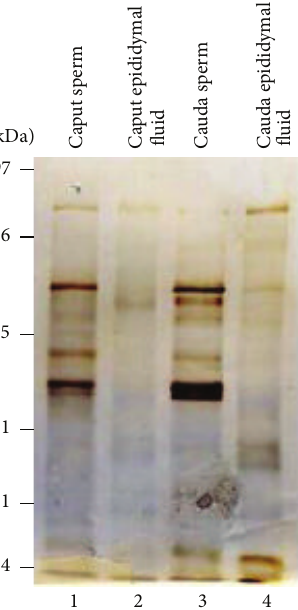
Figure 1: Ricinus Communis Agglutinin I (RCA) binding glycoprotein pattern of bovine caput and cauda epididymal spermatozoa and epididymal fluid. Western blots of Triton X-100-soluble fraction of bovine caput (lane 1) and cauda (lane 3) epididymal spermatozoa and caput (lane 2) and cauda (lane 4) epididymal fluid stained with biotinylated RCA exhibited the presence of an array of intense RCA binding polypeptides in the approximate molecular weight range of 55–38 kDa in addition to several faint RCA binding polypeptides. Among the